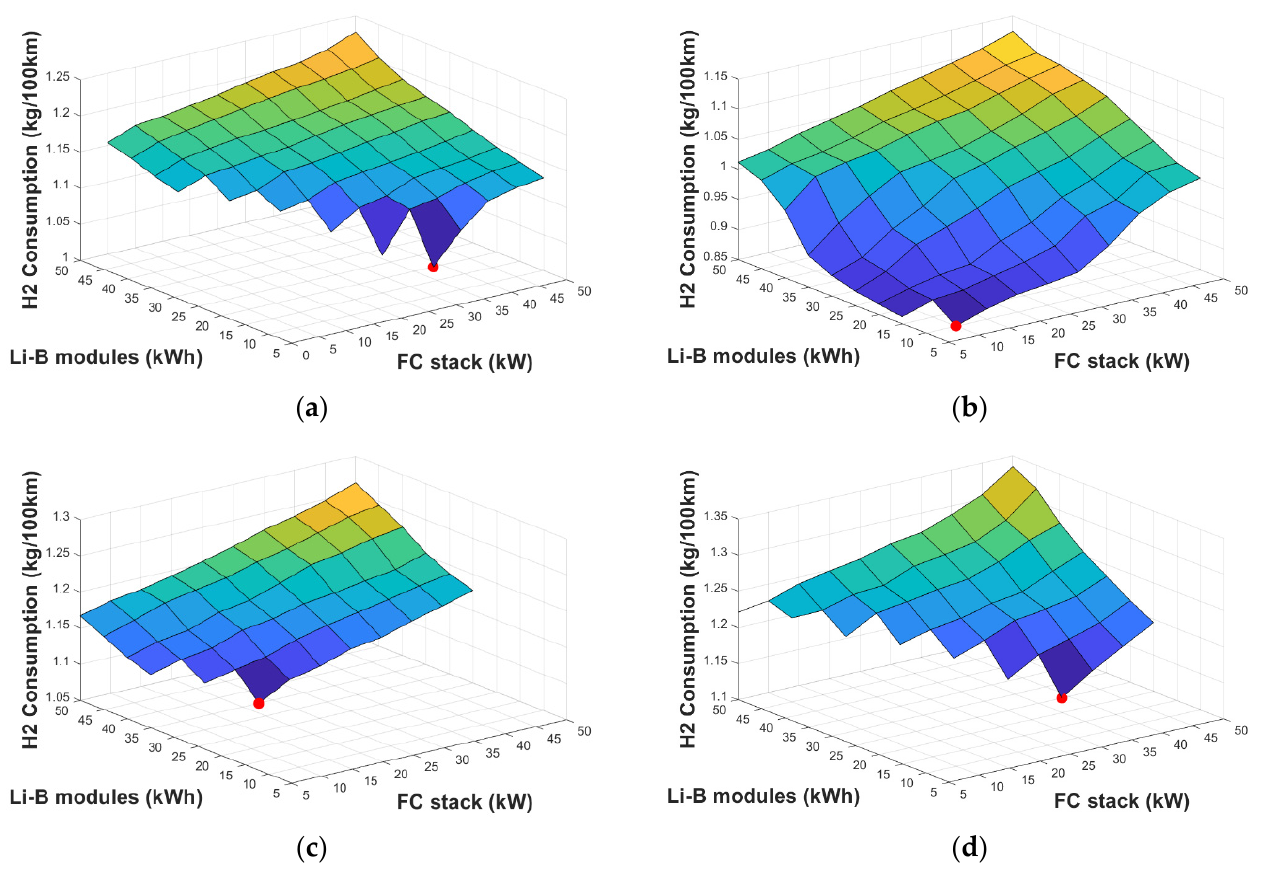
Figure 16. Fuel consumption of the FCV (Psplit3: δ = 1): ( a ) SFUDS, ( b ) FUDS, ( c ) NEDC, and ( d ) WLTP.